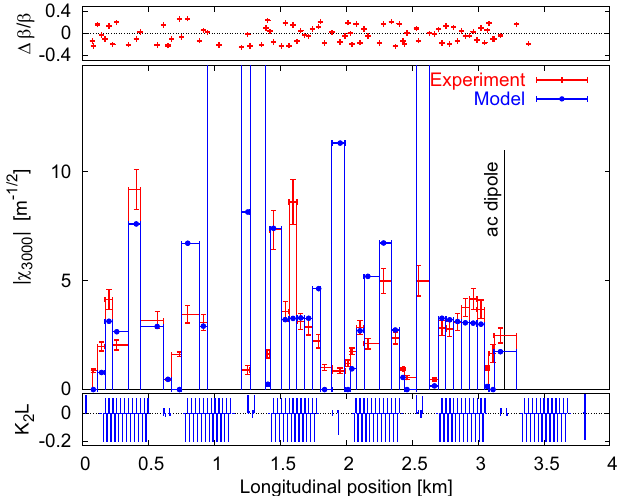
FIG. 4. (Color) Measurement of j f 0 bottom plot shows the sextupolar components of the